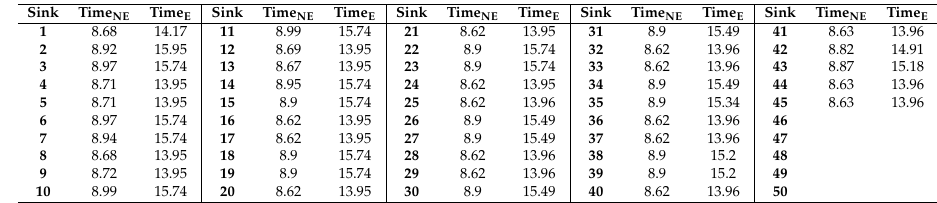
Table A8. Scenario 3: transmission times (in s) for each sink all over the transmission line. (Distance between poles is equal to 200 m, κ = 12, η = 2, NE means no encryption, E means encryption.)